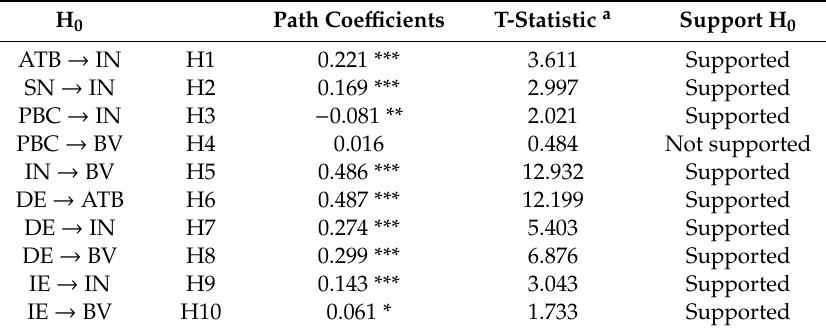
Table A5. Results of the structural model and hypothesis testing, n =